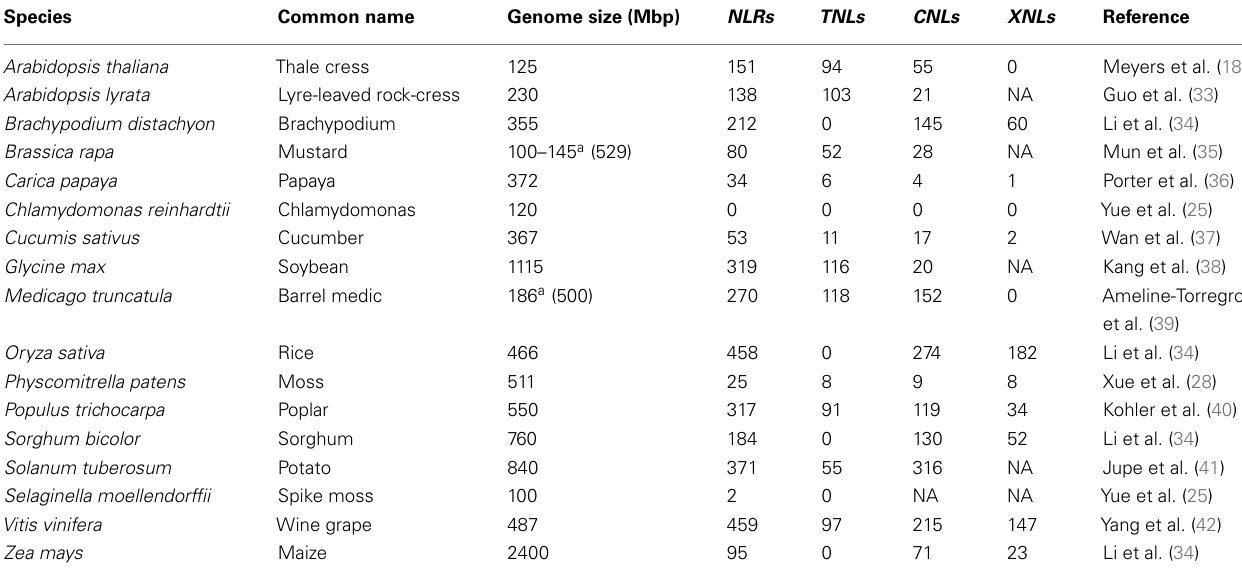
The table represents NLR and NLR-like gene numbers corresponding to NB-ARC-LRR-encoding genes.The numbers forTNLs, CNLs, and XNLs correspond to genes encoding either full-lengthTNLs, CNLs, XNLs, or the NB-ARC-LRR-containing proteins if these can be clearly assigned to one of the NLR types based on their motif composition at the NB-ARC domain. X refers to any N-terminal domain other thanTIR or CC. a Analyses based on partial genome sequence; the respective complete genome sizes are indicated in